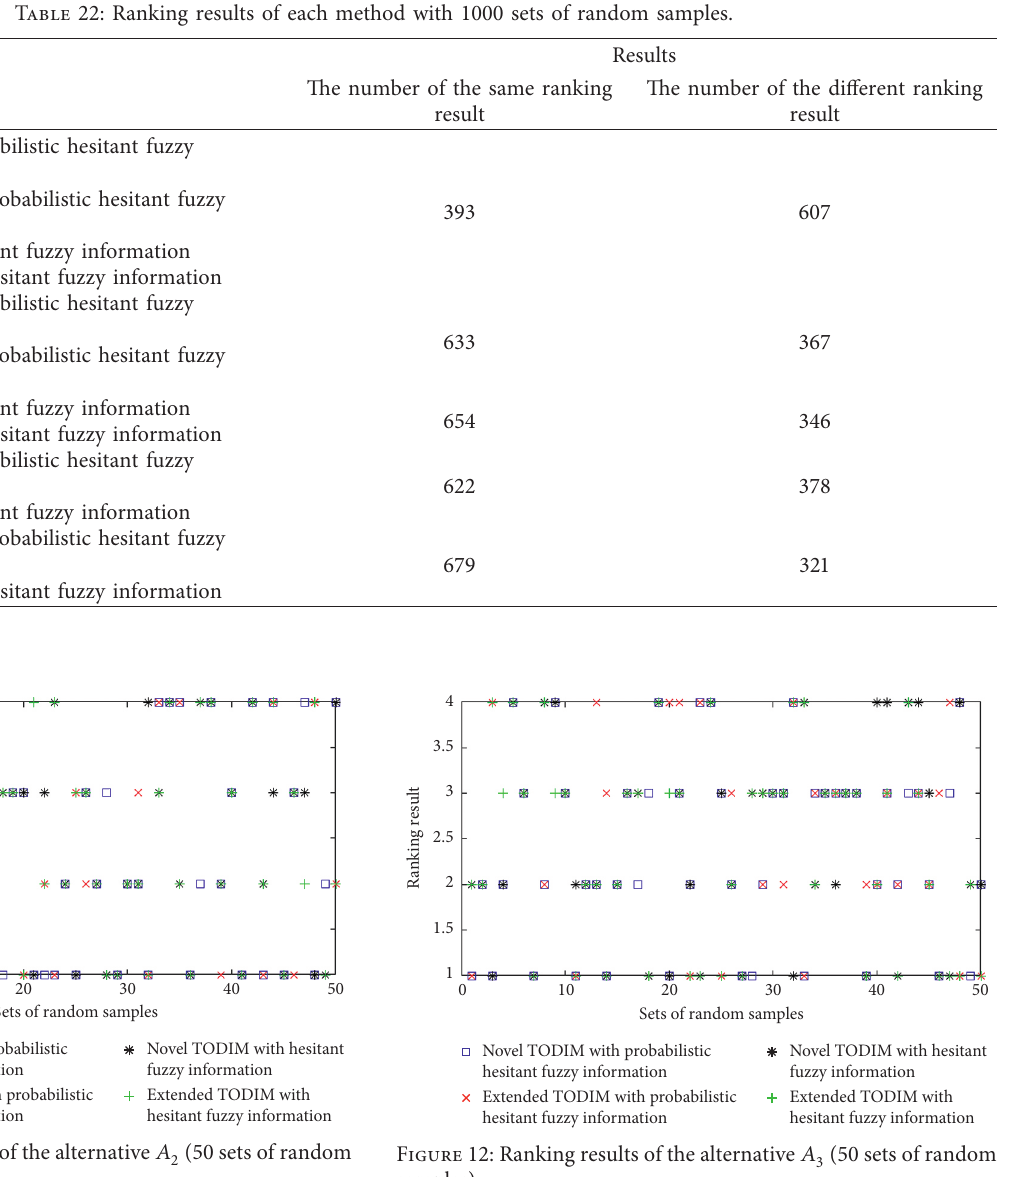
(50 sets of random 2